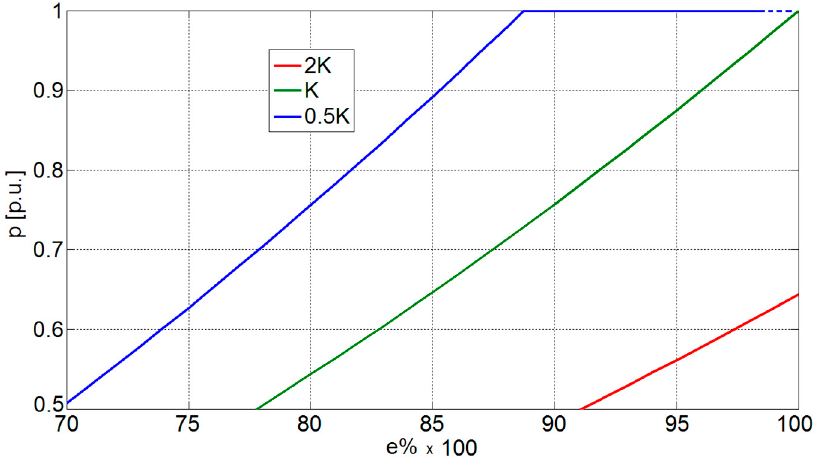
Figure 9. Power reduction function in the presence of different filtering solutions.